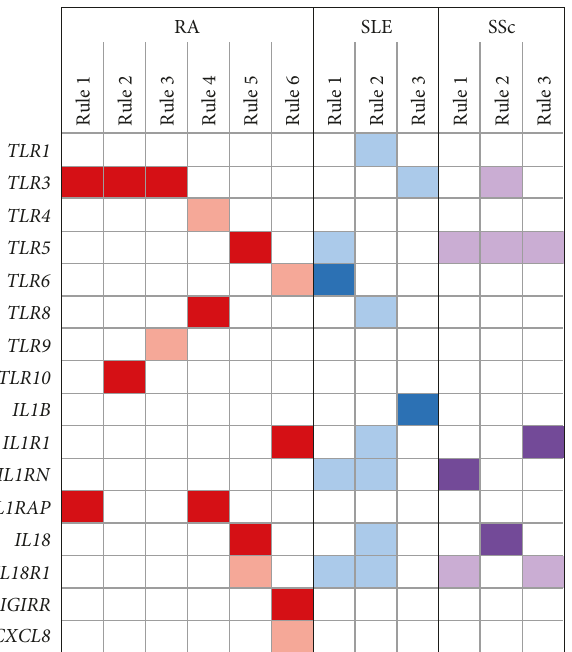
Figure 3: Association rules describing RA, SLE, and SSc. Association rule analysis revealed a minimum of six rules for RA, three rules for SLE, and three rules for SSc, able to discriminate among all studied diseases with the accuracy above 77%. Columns represent individual rules (combinations of genes and its expression levels characterizing the particular disease). Dark/light color means high/low gene expression levels (cut-o ff : mean gene expression of the whole data